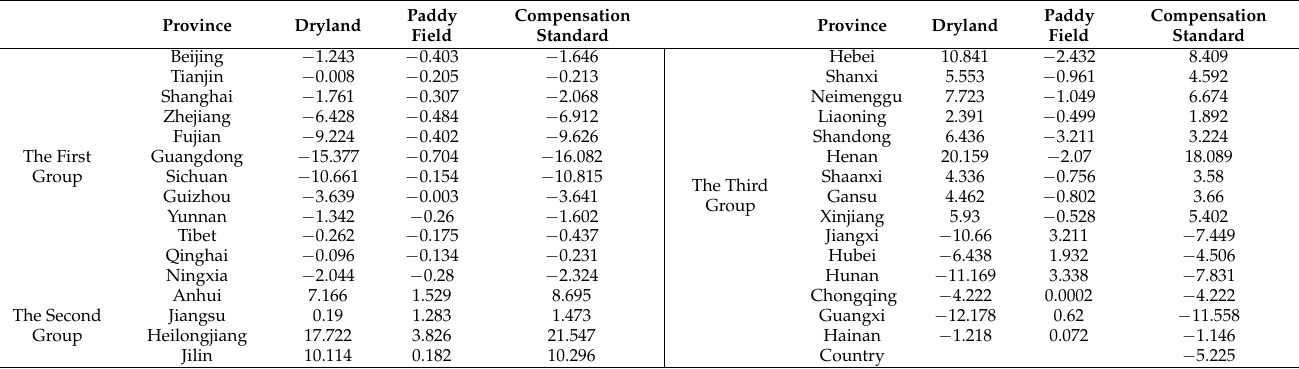
Table 2. The value of supporting services and ecological compensation standards for cross-regional occupation or supply of cultivated land in China’s provinces in 2018 (billion RMB).